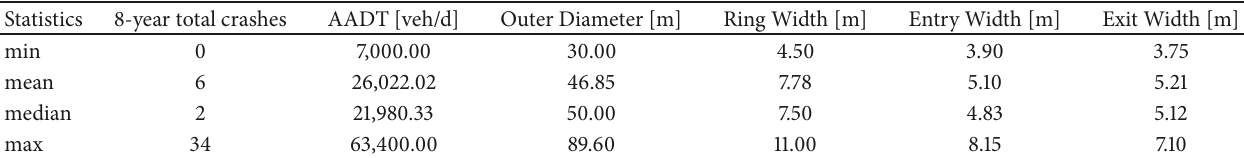
Table 2: The main statistics of the roundabout data sample.